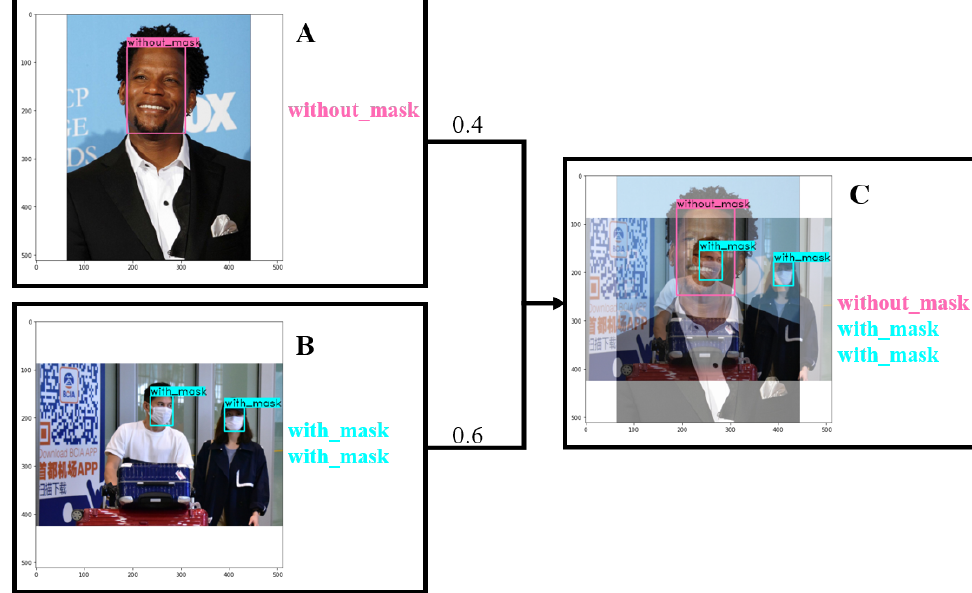
Figure 3. The visualization of the mixup augmentation with a blending ratio of 0.4:0.6. The labels of each image ( A , B ) are merged into a new list ( without _ mask , with _ mask , with _ mask ) for the new image ( C